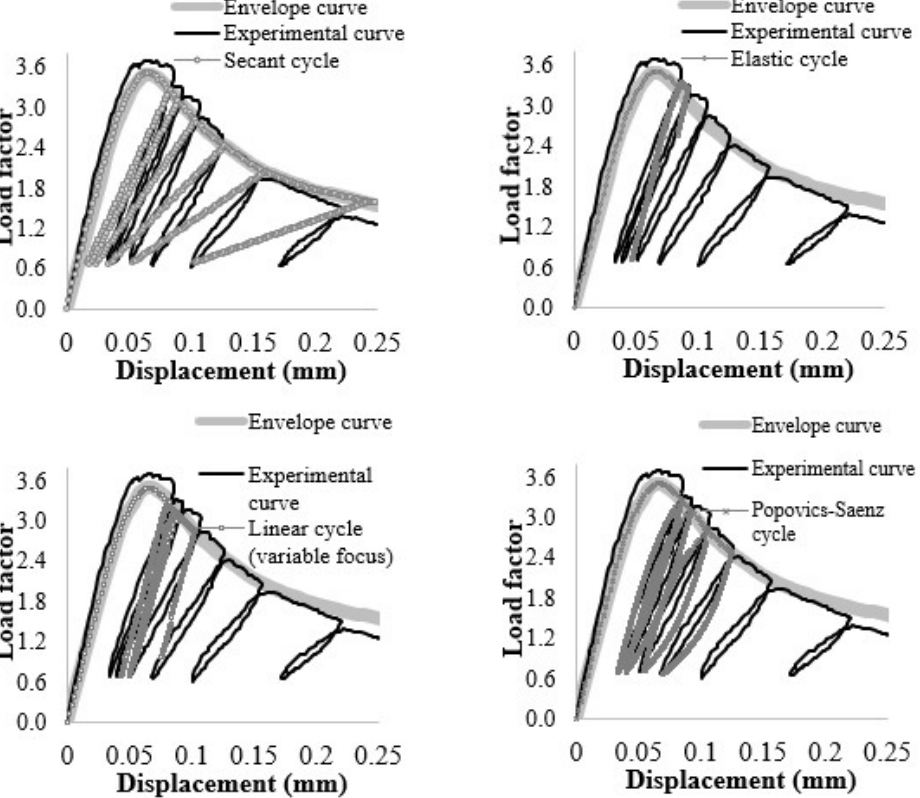
Figure 13. Three-point bending test: different strategies to represent the load